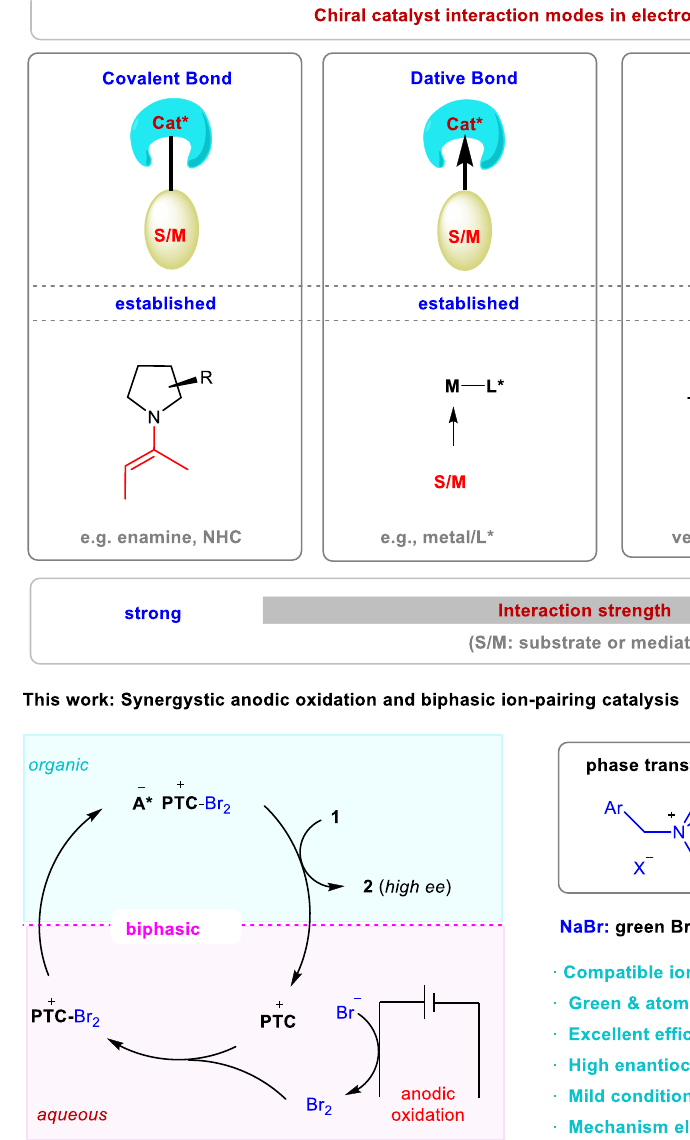
less successful. Ion-pairing catalysis remains elusive due to interference by the ionic electrolyte. Cat* chiral catalyst, S/M substrate or mediator. b The design principle of an electricity-driven asymmetric system using phase-transfer ion- pairing strategy. PTC phase-transfer catalyst, A* chiral phosphate